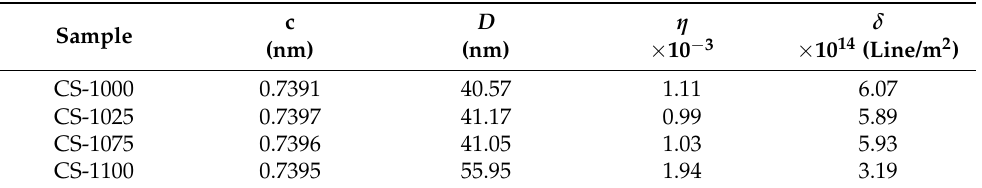
Table 1. The lattice parameter (c), the average crystallite size ( D ), lattice strain ( η ), and dislocation density ( δ ) of NSCTO ceramics.